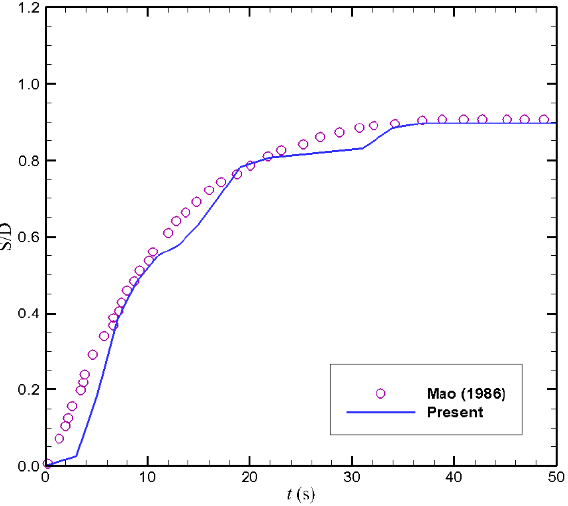
Figure 10. Evolution of scour depth.